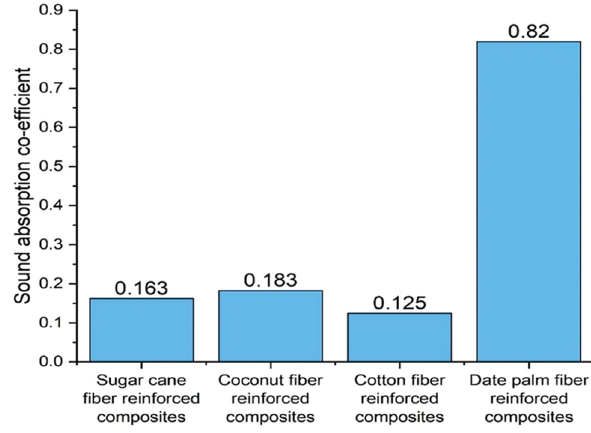
Figure 5: Sound absorption coe ffi cient of hybrid composites ( 180 )